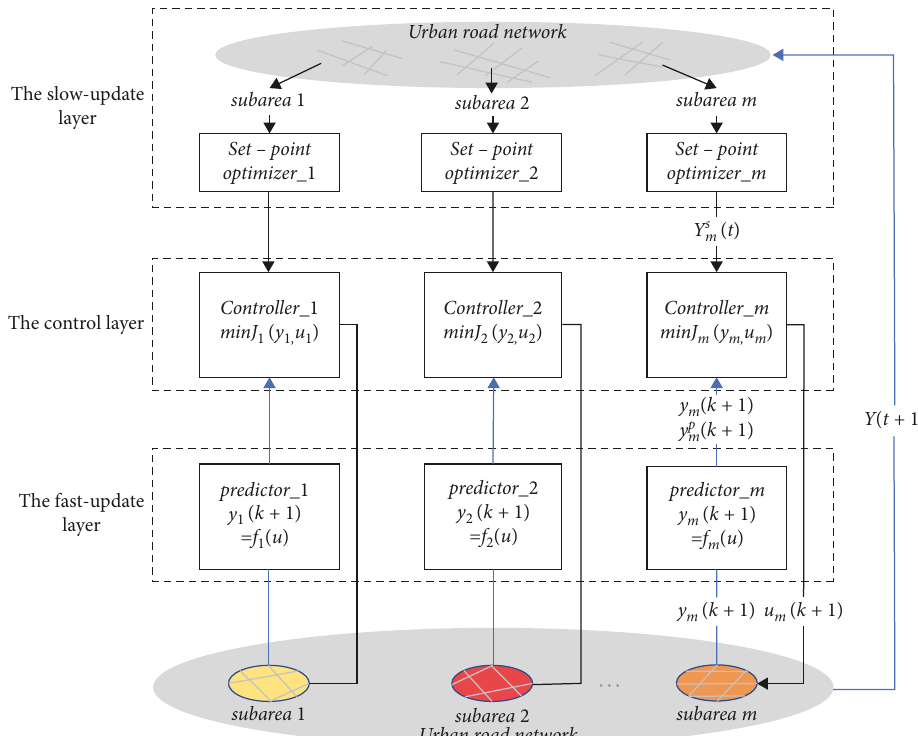
Figure 3: The framework of the distributed and robust MPC with a multihierarchical